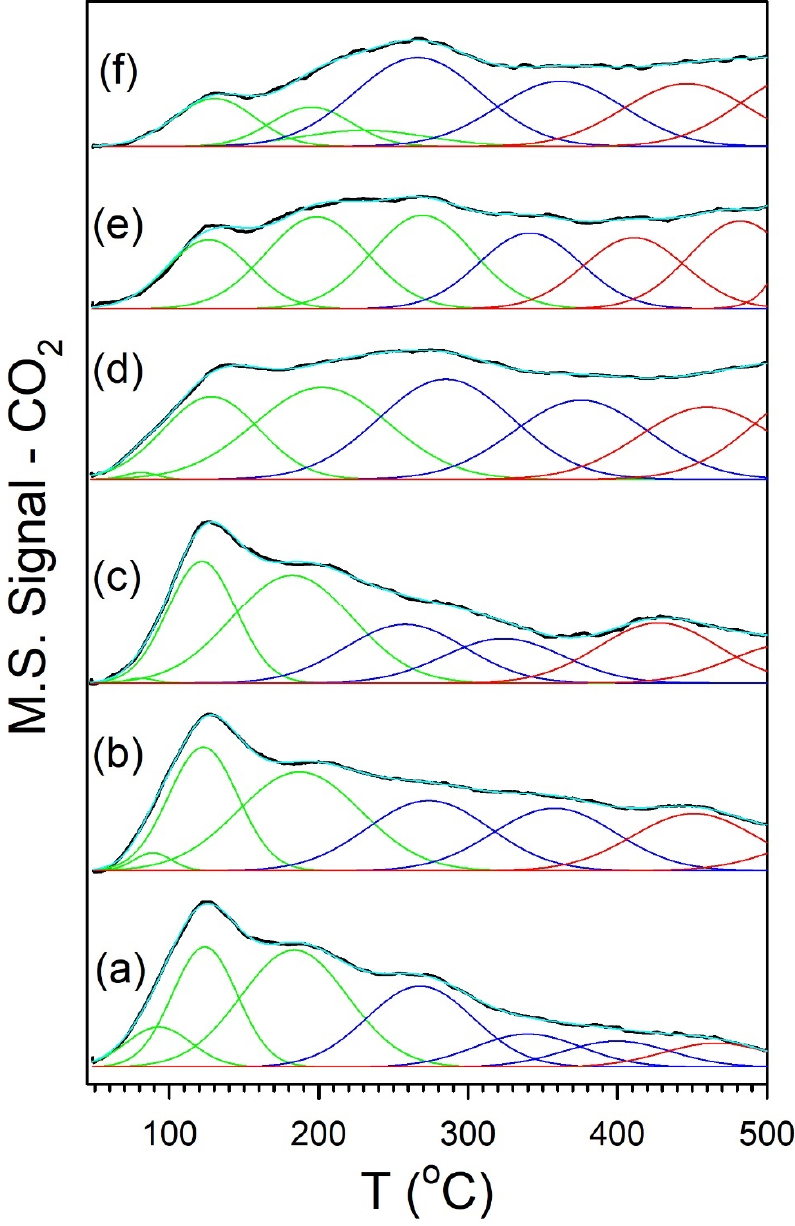
Figure 11. CO 2 TPD profiles for ( a ) 2%Pt/m-ZrO 2 , and the same catalyst with ( b ) 0.5%Na, ( c ) 1%Na, ( d ) 1.8%Na, ( e ) 2.5%Na, and ( f ) 5%Na. Maxima (green) < 250 ◦ C, (blue) 250–400 ◦ C, (red) > 400 ◦ C. Table 3. Results of fitting CO 2 TPD profiles with Gaussian peaks. Gaussian peak area percentages having maxima within various temperature ranges are shown.